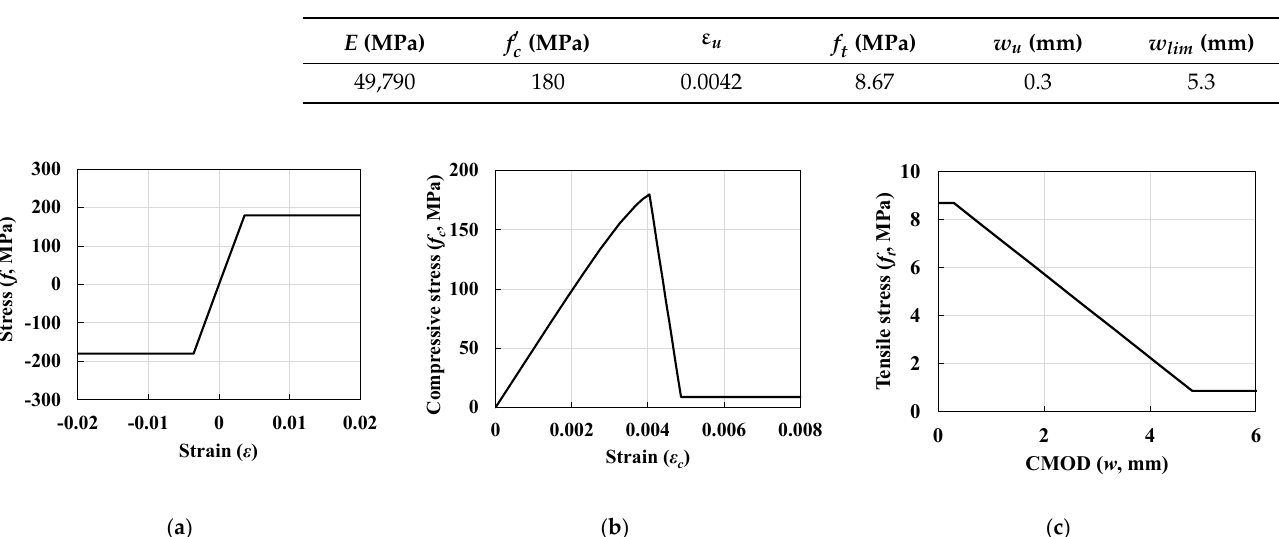
Figure 9. Tensile material behavior obtained via finite element analysis: ( a ) stress–strain relationship of the plastic material model for steel flanges, ( b ) compressive stress–strain relationship of the concrete damaged plasticity (CDP) material model for UHPC flanges, and ( c ) relationship between tensile strength and crack mouth opening displacement of the CDP model .